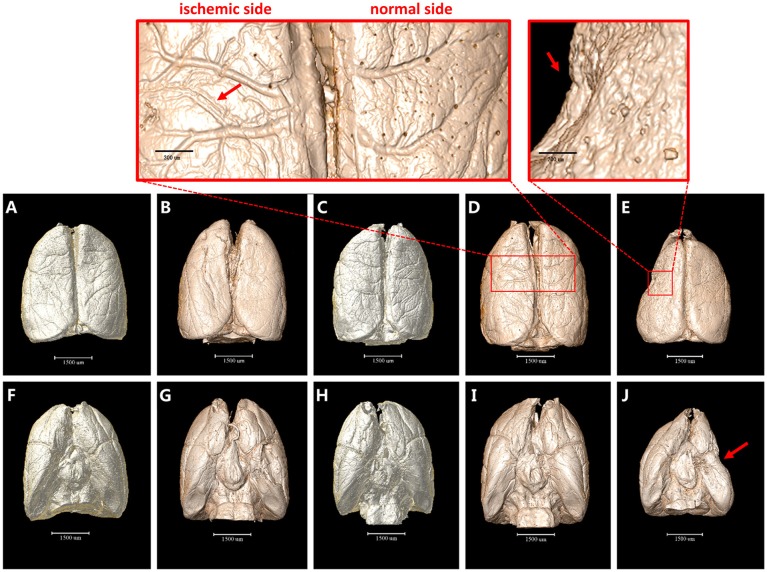
3D surface volume rendering images of brain after MCAO. (A–E) top view. (F–J) bottom view. (A) and (F) Sham operation group. (B,G) 4 h after MCAO. (C,H) 6 h after MCAO. Leptomeningeal vasculatures at 4 h and 6 h after ischemia did not exhibit obvious changes compared to sham operation group. (D,I) 3 d after MCAO. Ischemic side began to lose their integrity and organization with small vessels looking stiff and distorted as directed by red arrow in the magnified panel. (E,J) 18 d after MCAO. Ischemic side atrophied (red arrow) and collapsed and vascular network decreased. Scale bars: 1,500 μm (A–J), 300 μm (top left) and 200 μm (top right).